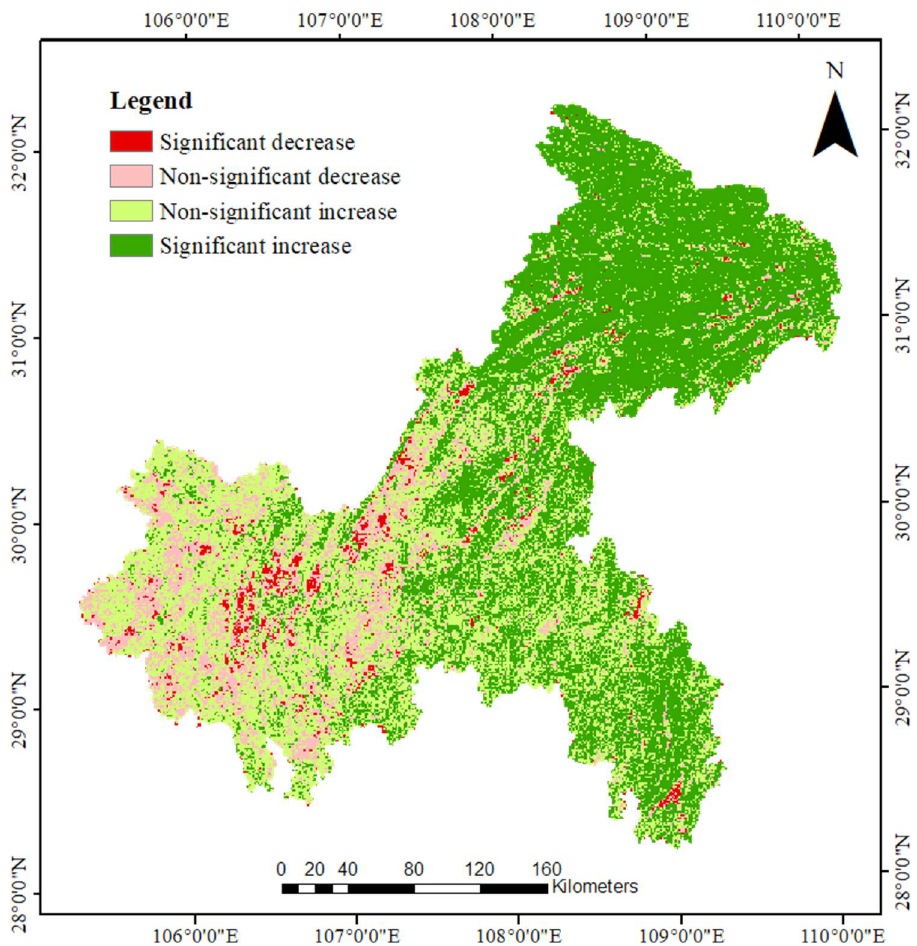
Figure 7. Impact of human activities on changes in vegetation cover.